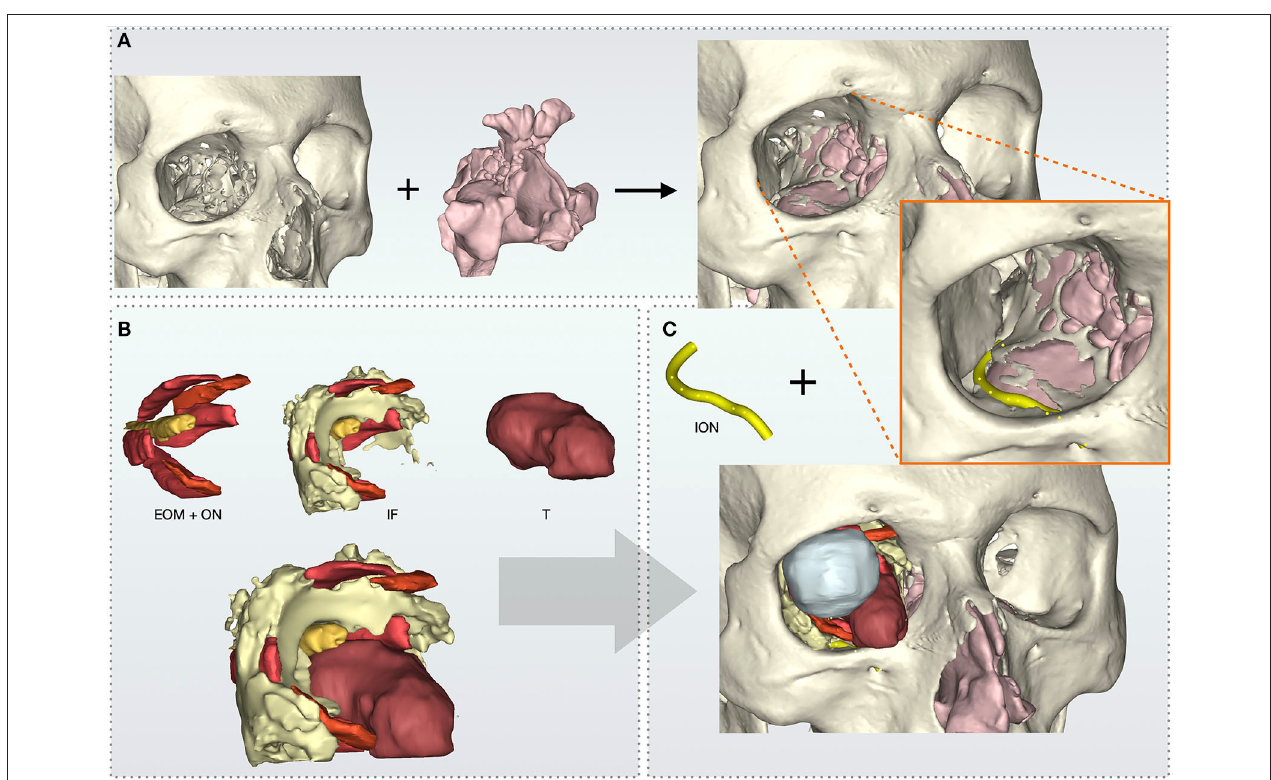
FIGURE 2 | Virtual model reconstruction workflow of intraorbital structures, skull, and paranasal sinuses. (A) Paranasal sinuses model is composed with skull. (B) Extraocular muscles (EOM) and optical nerve (ON) are grouped with intraorbital fat (IF) and tumor’s (T) models. (C) Complete anatomical model with the addition of infraorbital nerve